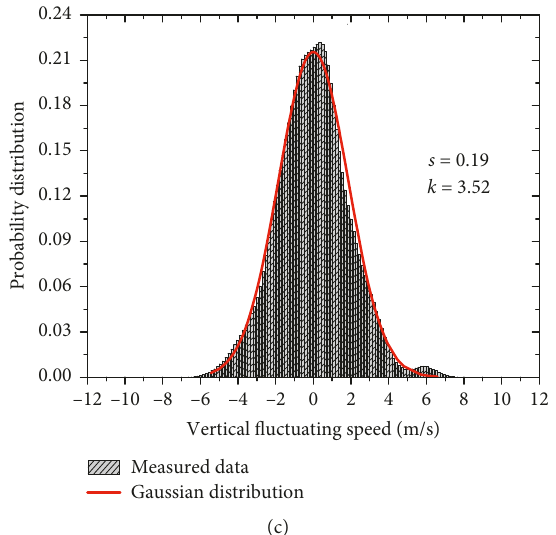
Figure 12: Probability density distribution of wind speed. (a) Longitudinal direction. (b) Lateral direction. (c) Vertical direction.